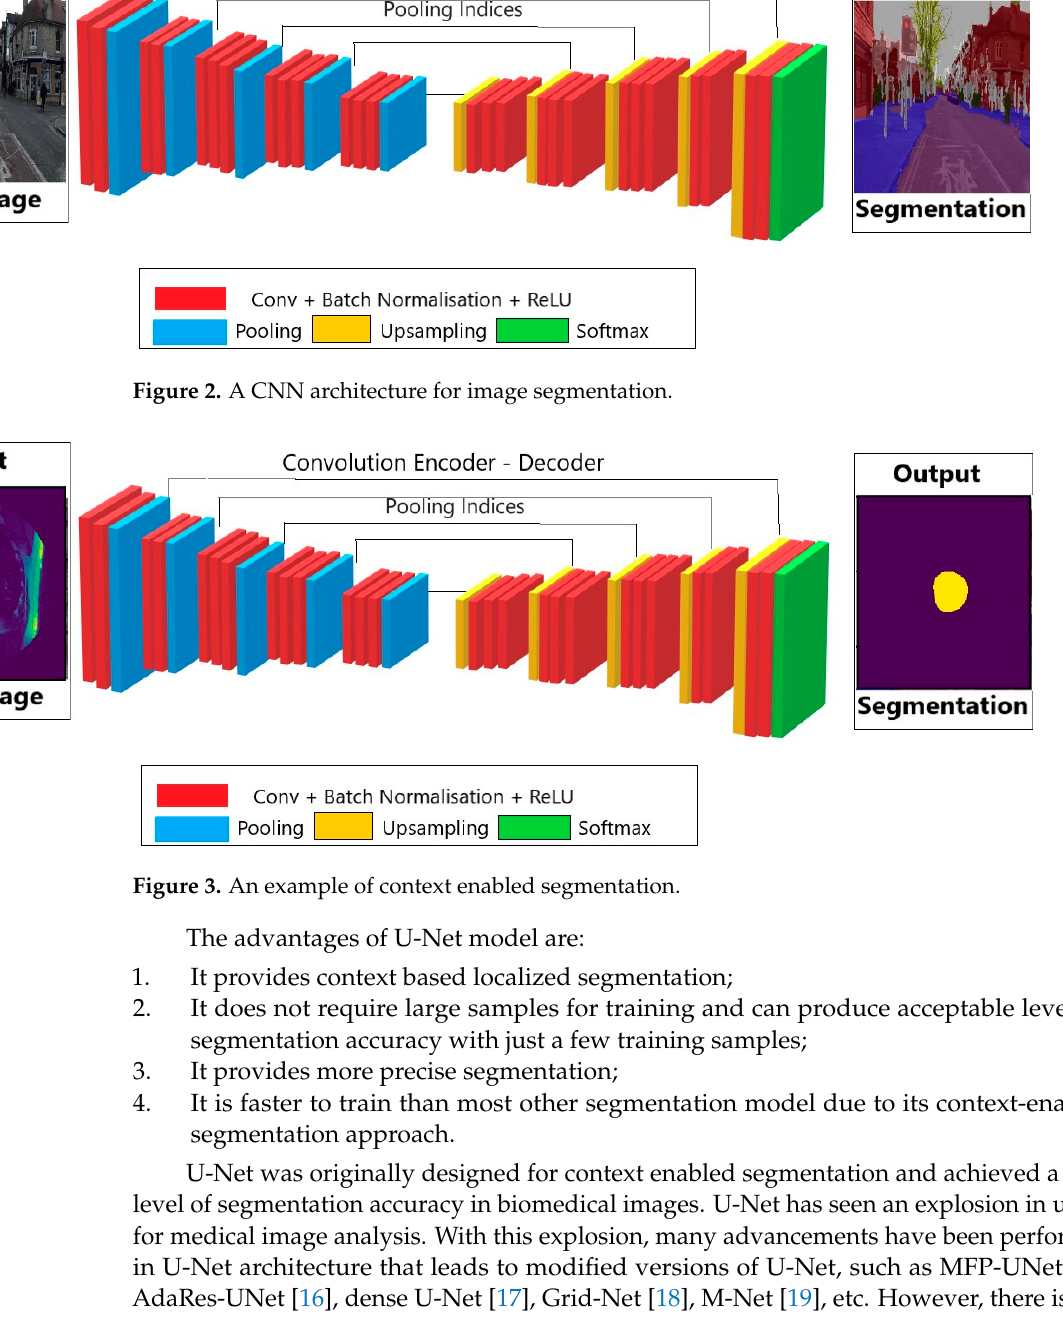
Figure 2. A CNN architecture for image segmentation.